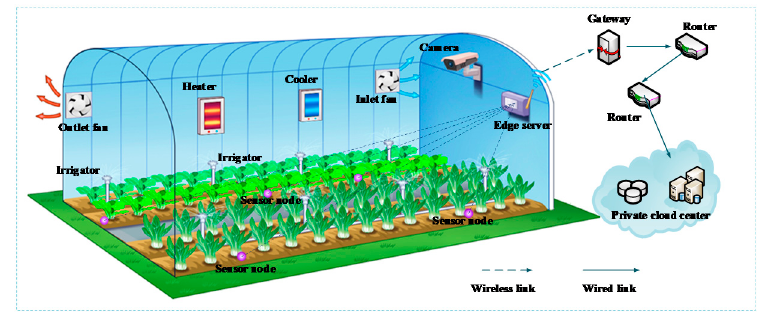
Figure 2. The block diagram of the experiment platform.